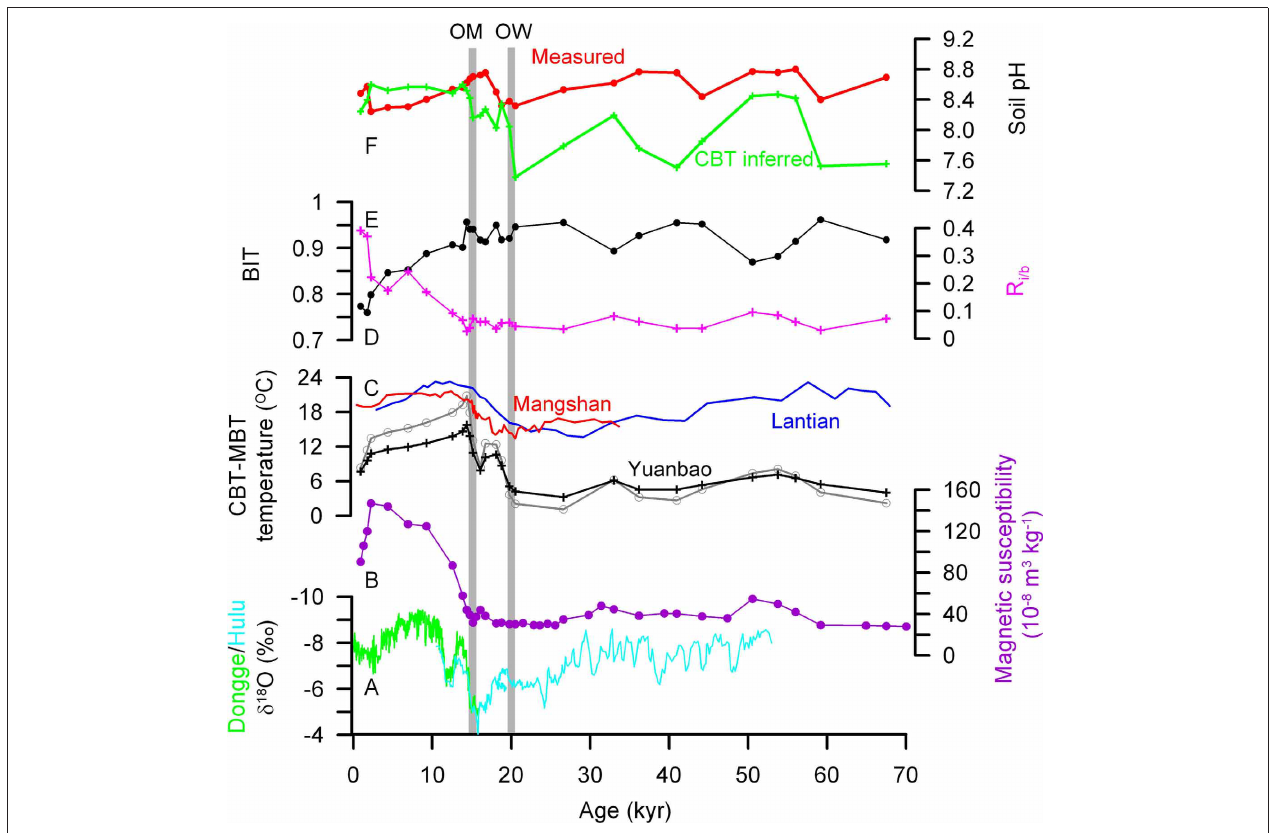
FIGURE 5 | GDGT derived proxy records down the sequence at Yuanbao section and their comparison to speleothem δ 18 O. (A) Speleothem δ 18 O from Dongge and Hulu cave (Wang et al., 2001; Dykoski et al., 2005); (B) magnetic susceptibility; (C) MBT-CBT derived temperature. Black and gray